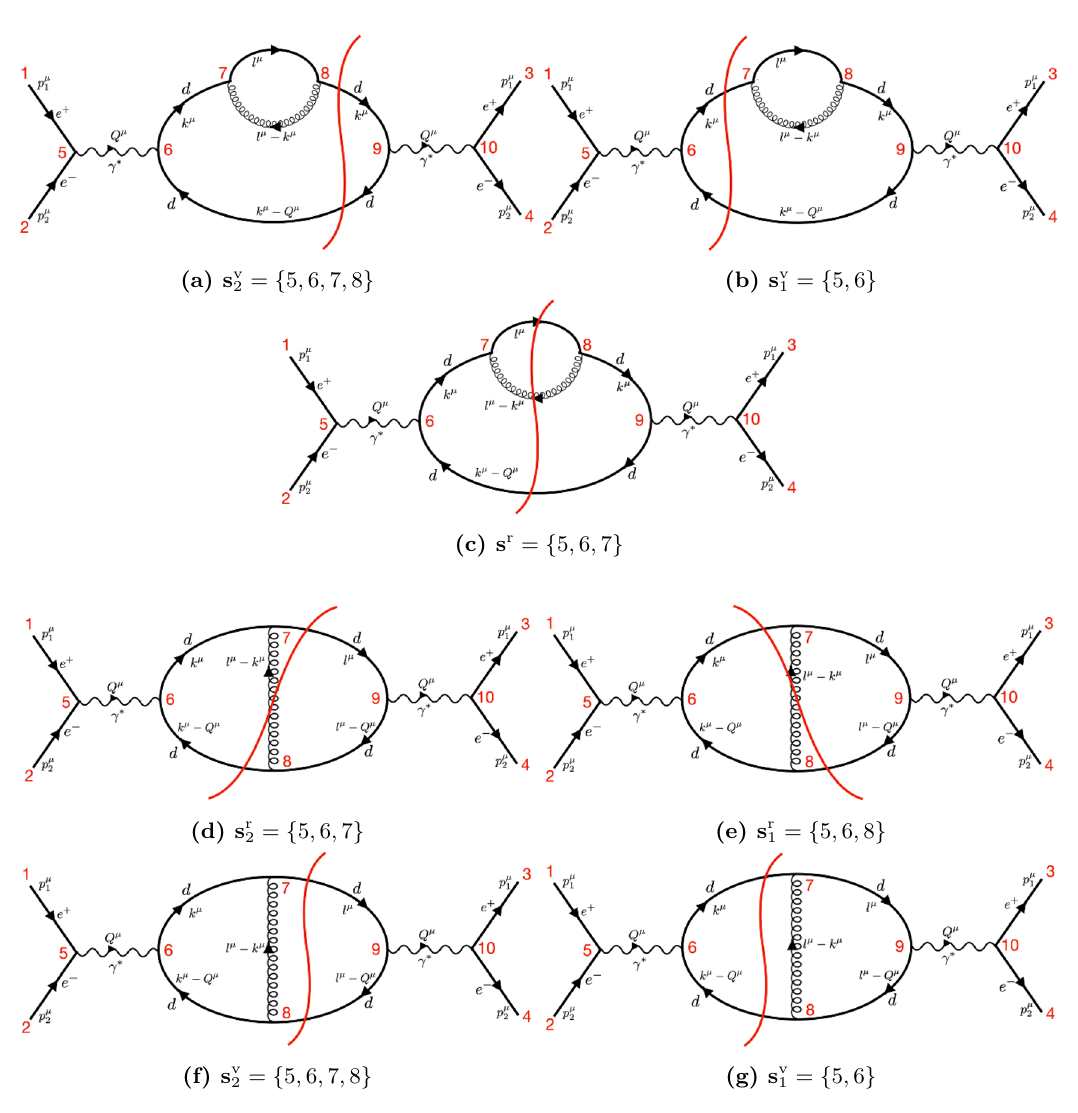
Figure 2. All three Cutkosky cuts of the self-energy supergraph (2a, 2b and 2c) and all four cuts of the double-triangle supergraph (2d, 2e, 2f and